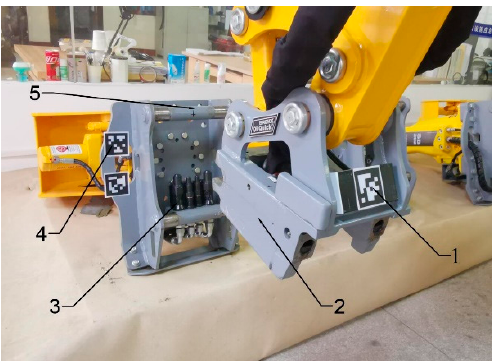
Figure 5. ( a ) Measured position error data of 𝑒 (cid:3024) . ( b ) Distance and angle error analysis of 𝑒 (cid:3024) .